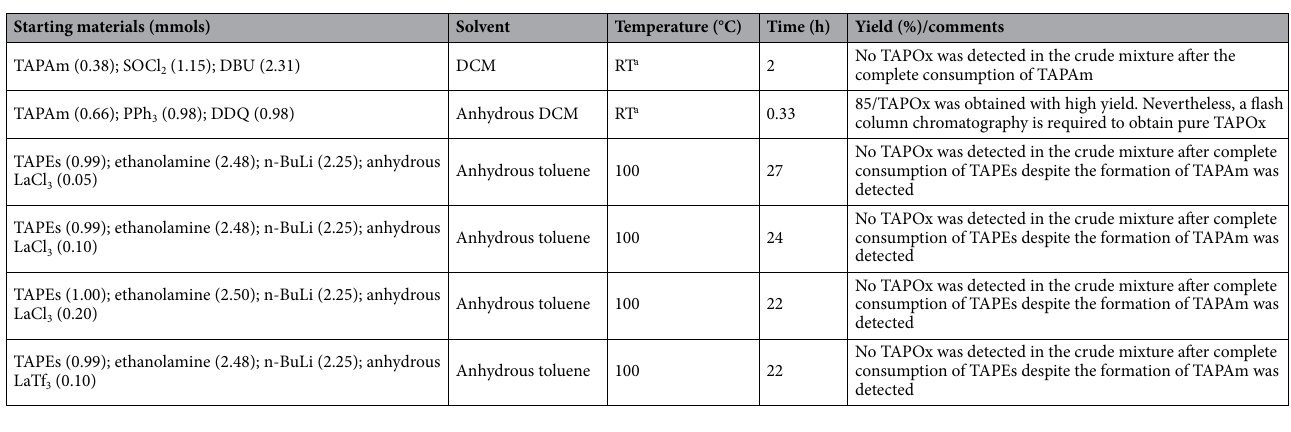
Table 2. Starting materials, solvent, reaction conditions and results obtained in the chemical reactions performed in the synthesis of TAPOx. a RT, room temperature = 20 ± 3 °C.